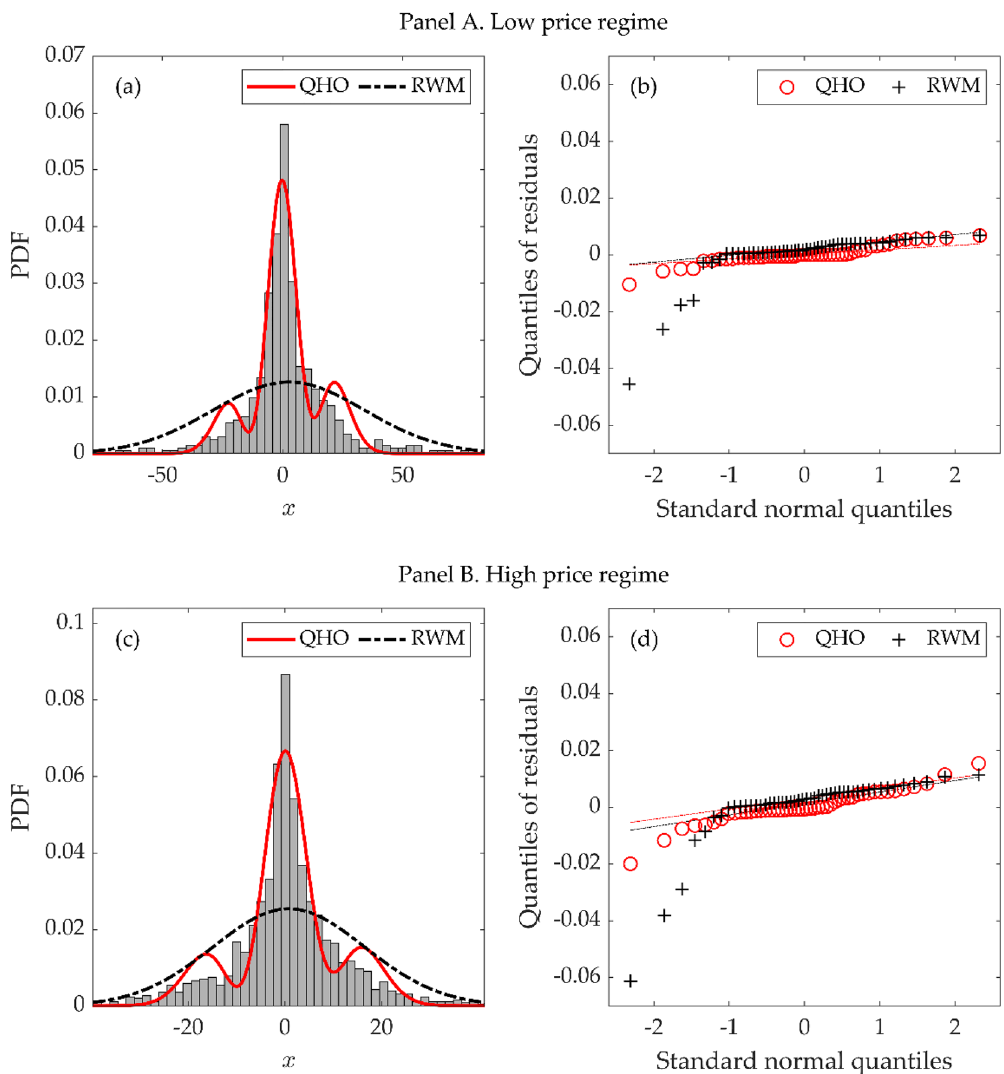
Figure 1. Model estimation results. Panels ( a ) and ( c ) plot the PDFs of each estimated model in the low and high price regimes, respectively. Panels ( b ) and ( d ) describe Q–Q plots for the residuals of each model by standardized normal order, plotted with a regression line, in both regimes. Both models are estimated using a daily sampling interval ( q = 1). Outliers that deviate from the mean by more than 2.58